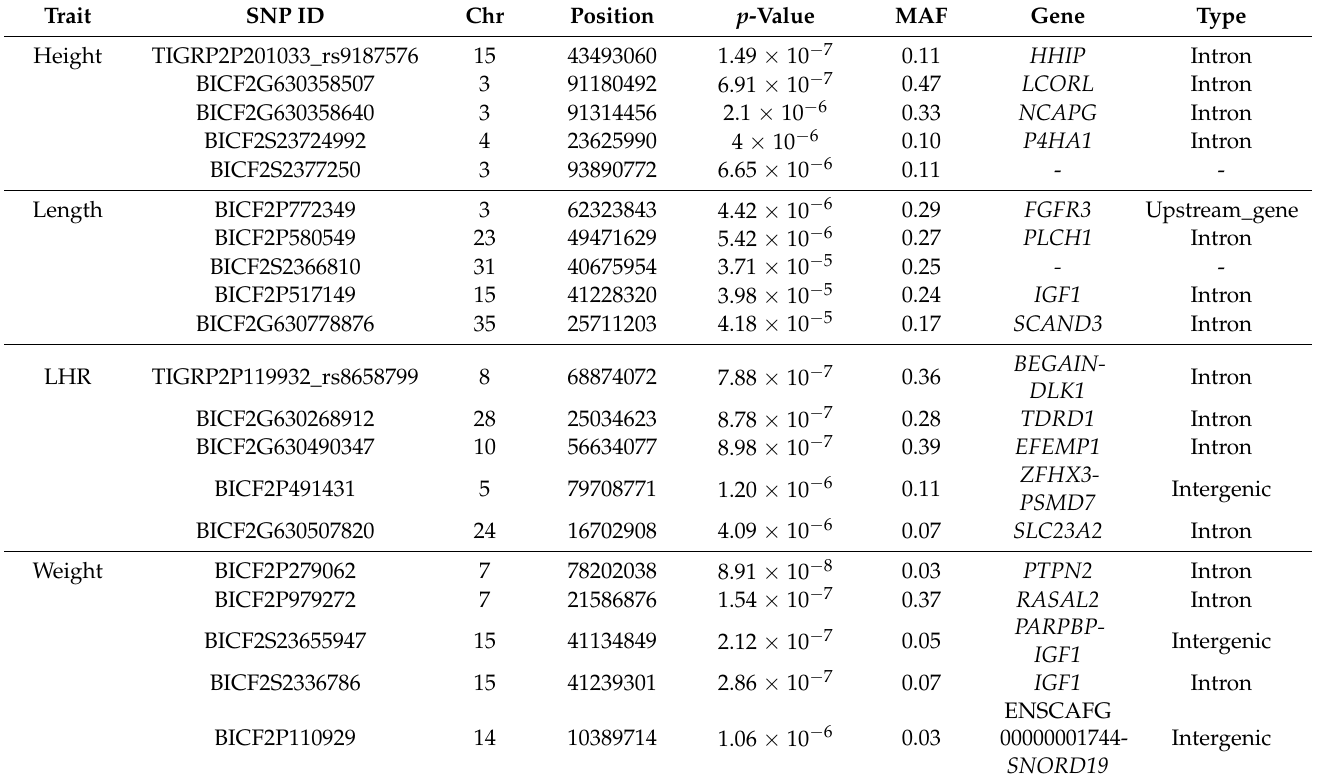
Figure 6. Manhattan plots of mapped single nucleotide polymorphism (SNP) markers associated with body weight. Red line designates the Bonferroni-corrected significance threshold level of p < 4 × 10 − 7 and blue line shows genome wide significant threshold level of p < 5 × 10 − 5 . The quantile-quantile (Q-Q) plot of the GWAS is shown in the right side. GWAS, genome-wide association study. Table 2. Top 5 SNPs associated with height, length, LHR and body weight in Jindo dog.